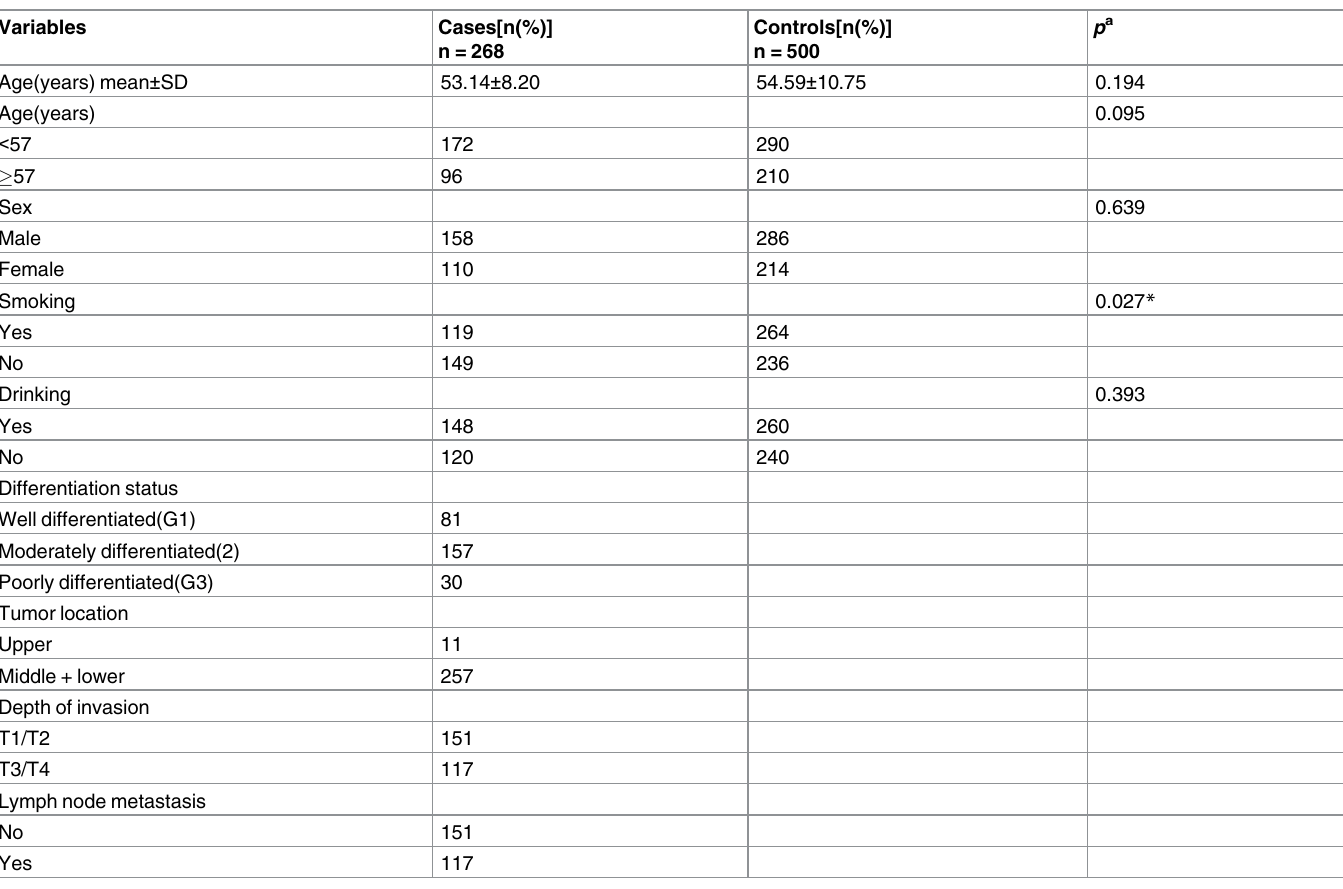
Table 1. Characteristics of ESCC cases and